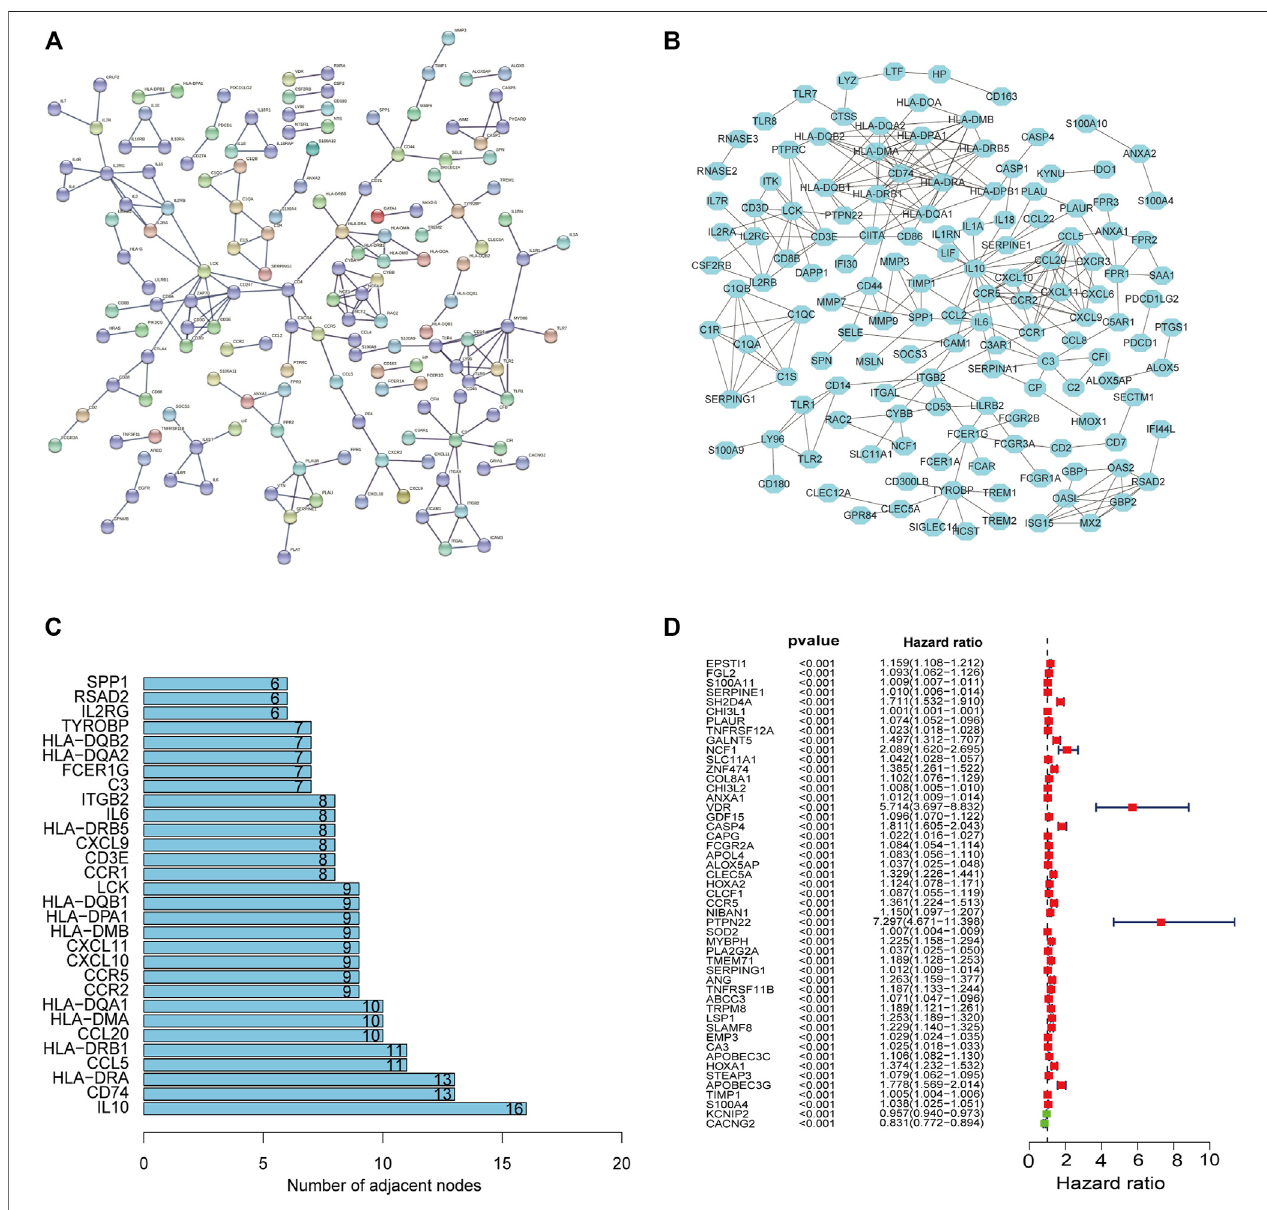
FIGURE 5 | PPI network and univariate Cox regression analyses. The PPI network based on the STRING con fi dence score > 0.9 (A) . The visualization of the PPI network (B) . The top 30 genes ordered by the number of nodes (C) . Univariate Cox analyses fi ltered 49 genes ( p < 0.001) related to prognosis (D) .